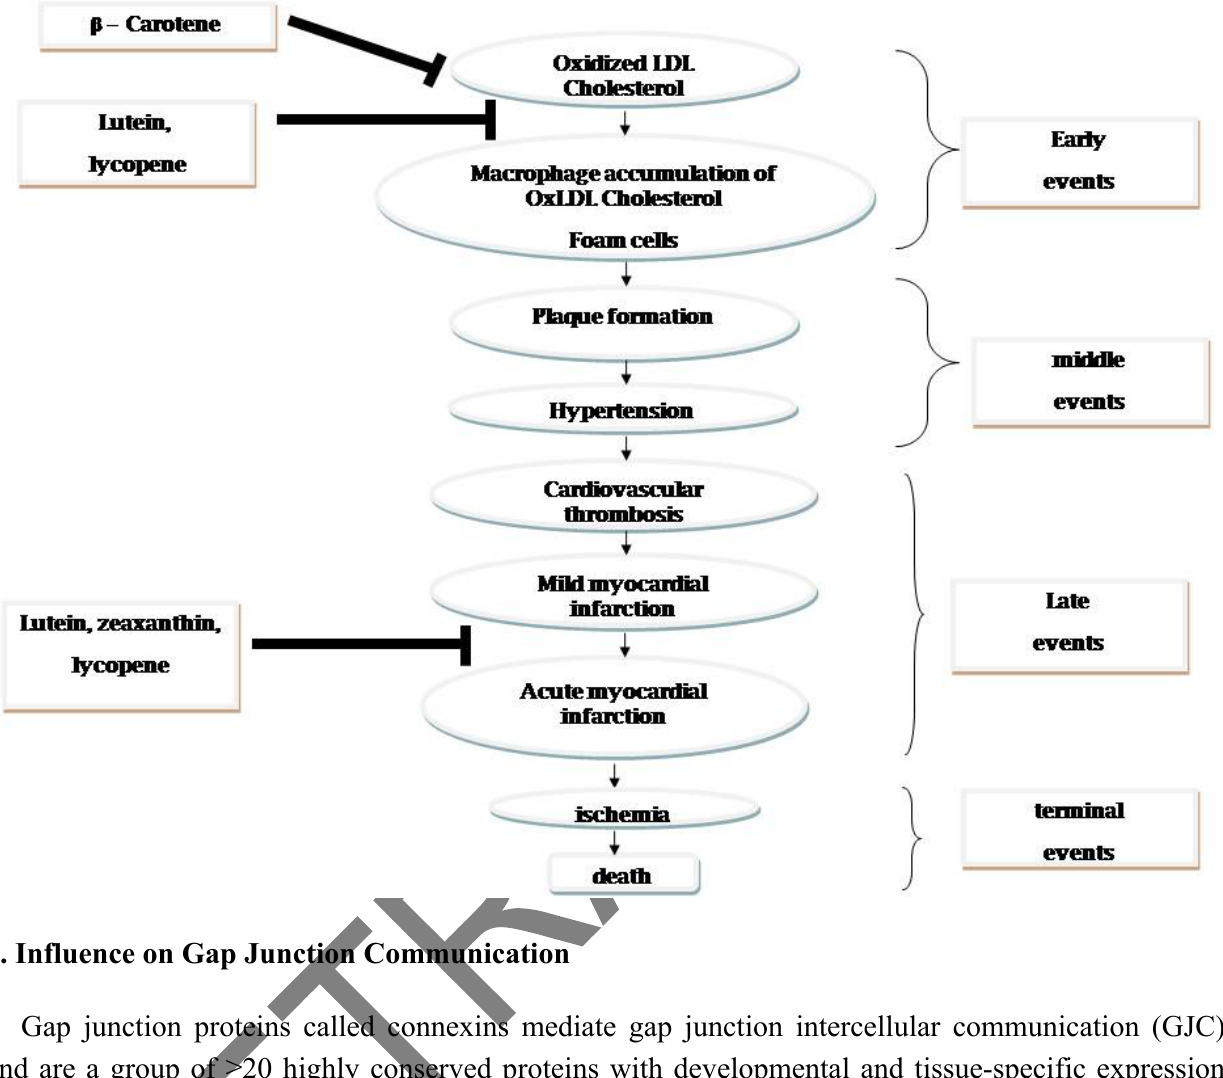
Figure 2. Schematic representation of carotenoids’ action on